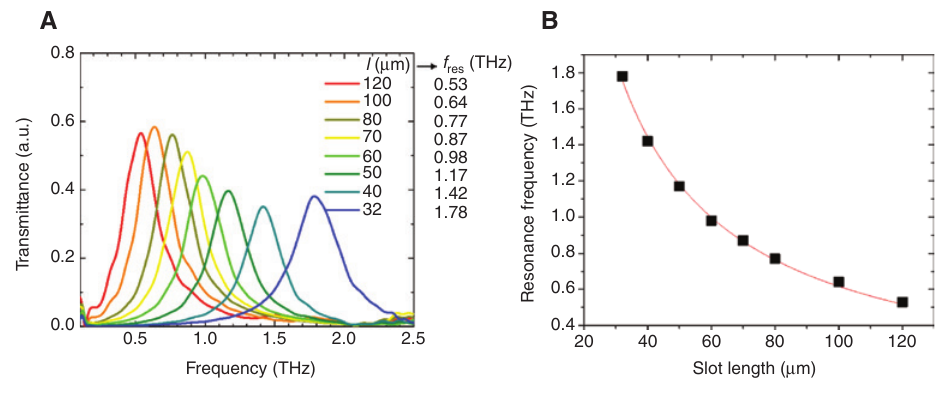
Figure 17: Transmittance with varying slot length. (A) Measured THz transmittances for various slot arrays. (B) The resonance frequencies for different slot arrays are plotted in terms of the slot